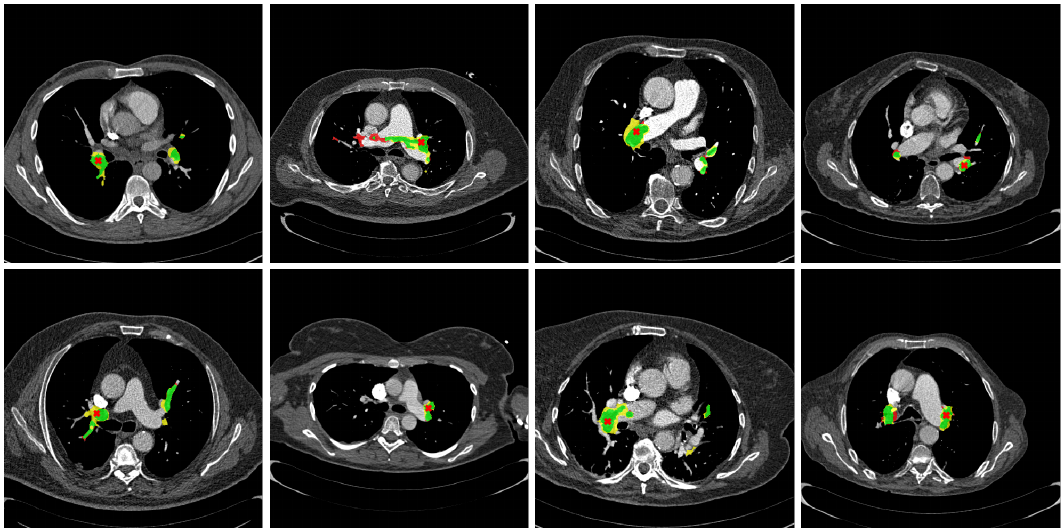
Figure 3. Network outputs after thresholding and closing operations compared to the reference standard segmentation with (cid:101) = 0 mm. True positives are shown in green, false positives in yellow, and false negative in red. A predicted clot coordinate for that slice level is represented as a red cross.